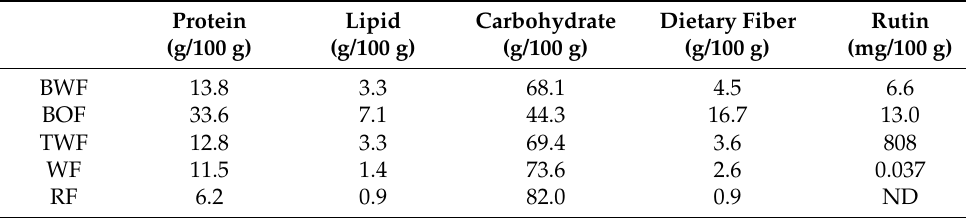
BWF, buckwheat whole flour; BOF, buckwheat outer flour; TWF, Tatary buckwheat whole flour; WF, wheat flour; RF, rice flour; ND, not